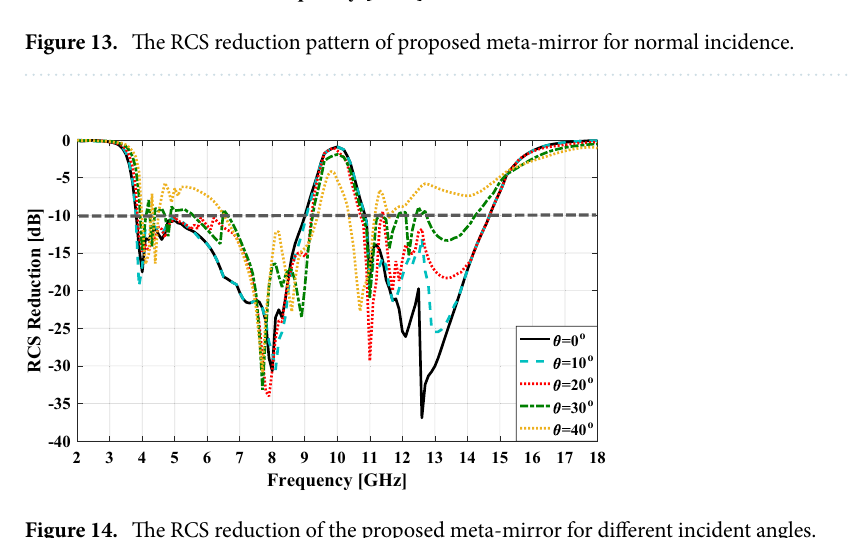
Figure 14. The RCS reduction of the proposed meta-mirror for different incident